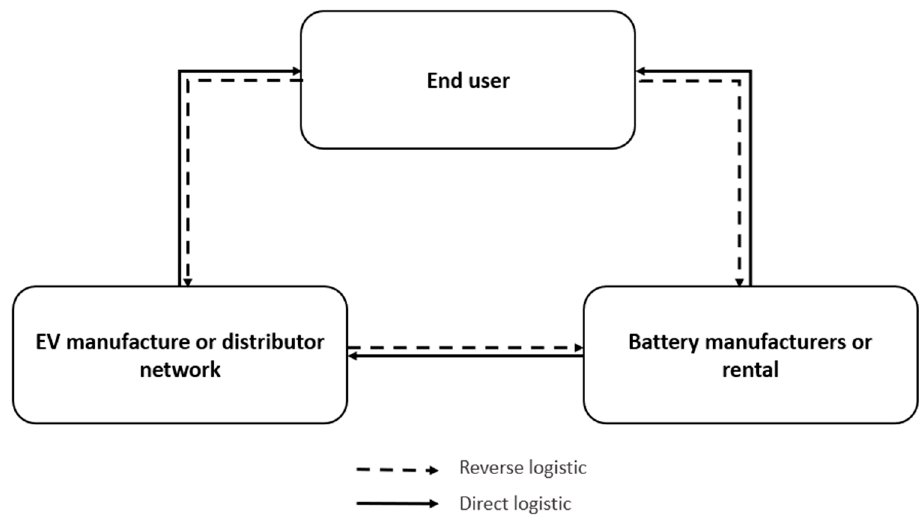
Figure 4. Lithium-ion battery reverse chain in Japan. Adapted from [33].